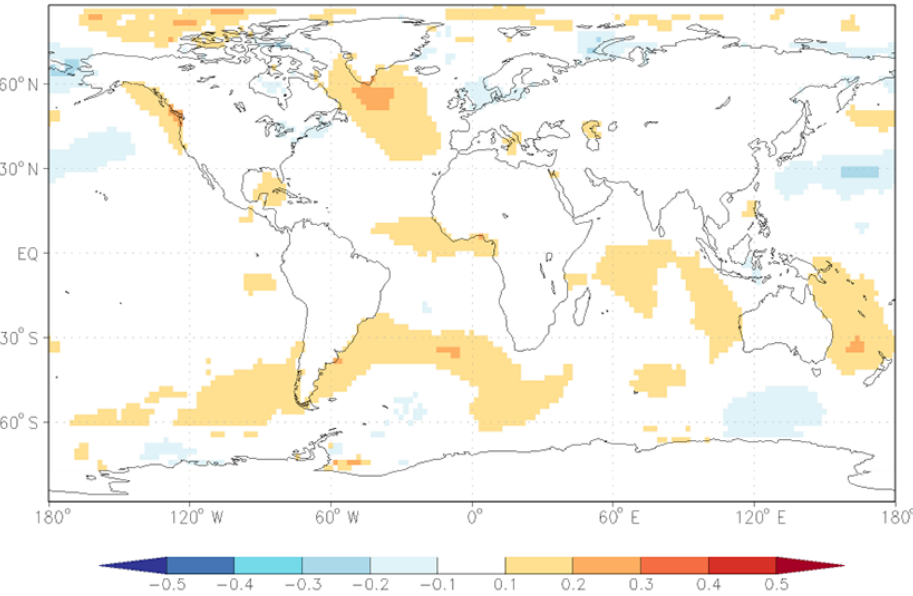
Figure 6. Correlation coefficient between central US Gulf Coast spatial and annual maximum of 3-day extreme precipitation intensity and annual mean SST (ERSST v4) with a linear regression on the global mean temperature removed at each grid